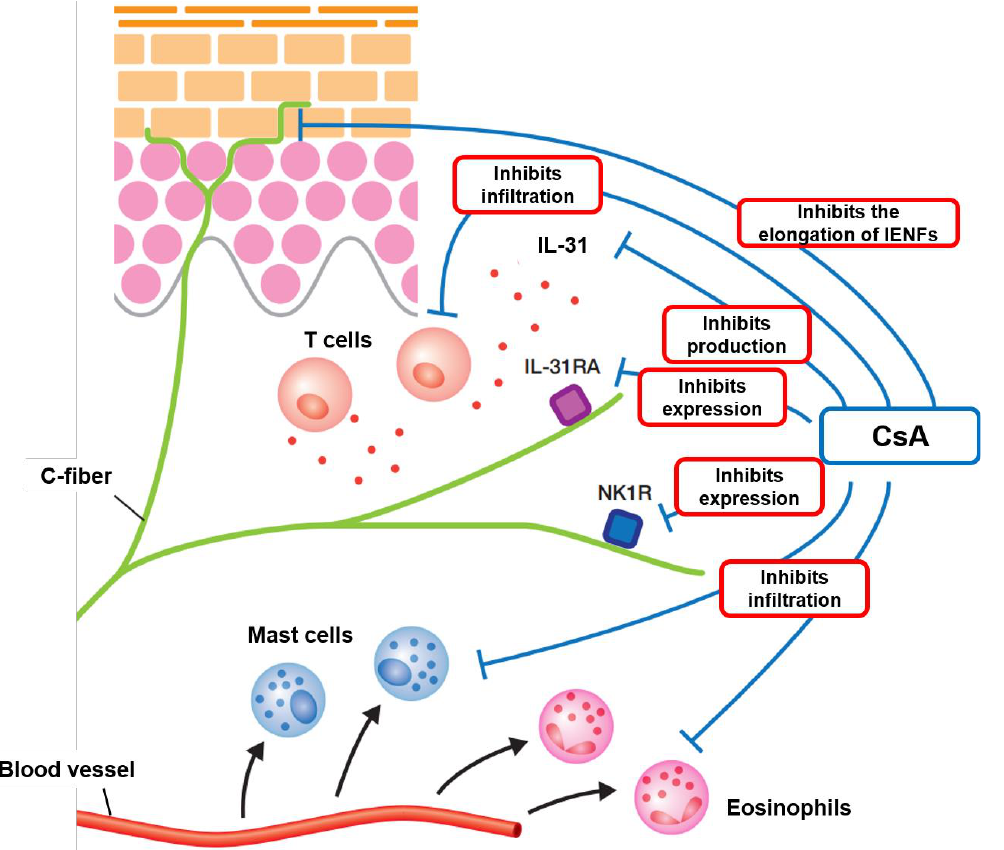
Figure 2. Antipruritic mechanism of CsA for intractable itch in AD. CsA down-regulates expressions of IL-31RA and NK1R in peripheral nerves. CsA also inhibits the infiltration of immune cells, such as CD4 + T cells, mast cells, and eosinophils. In addition, CsA reduces the perception of itch stimuli by suppressing the proliferation of IENFs.